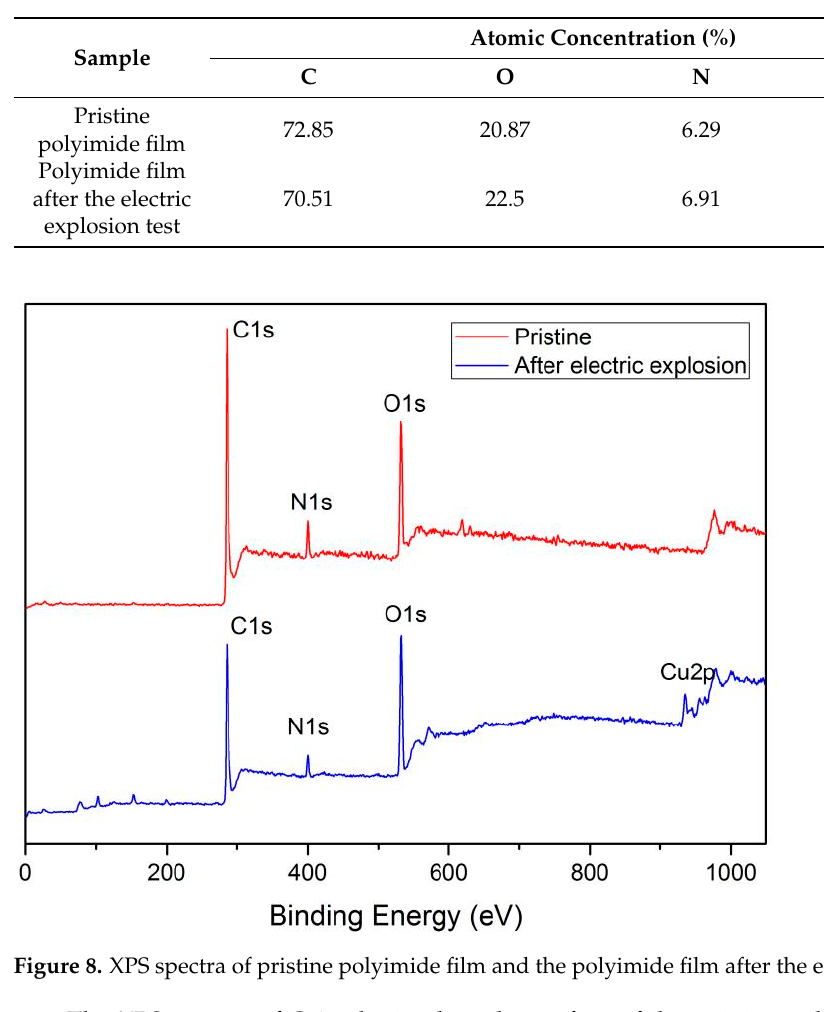
Figure 8. XPS spectra of pristine polyimide film and the polyimide film after the electric explosion. The XPS spectra of C 1s obtained on the surface of the pristine polyimide film are presented in Figure 9a. The prominent peak located at 284.8 eV corresponds to the carbon atoms of two benzene rings of the ODA structure. The peak at 285.8 eV is related to the C–N bonds. The other two peaks at 286.6 eV and 288.3 eV are attributed to ether group C–O in the ODA unit and carbonyl group C=O in the imide systems of the ODPA unit, respectively [25–28]. After the electric explosion test, the relative intensities of